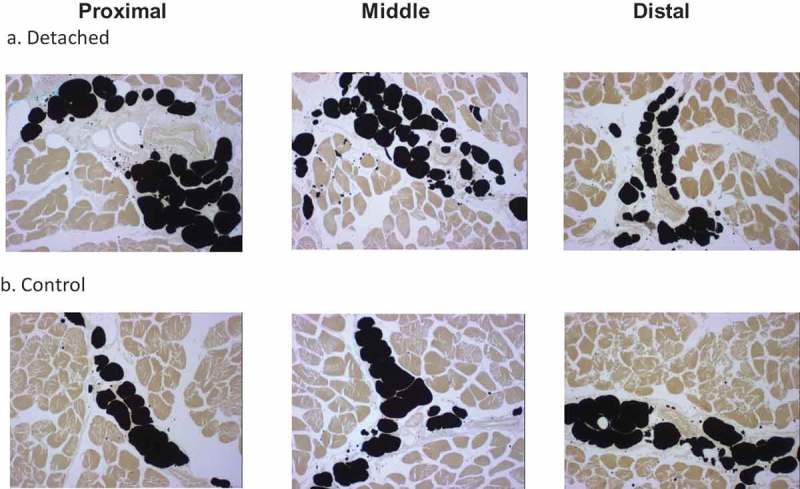
Representative micrographs of adipocytes in the proximal, middle and distal quarters of the SSP muscle. (a). SSP muscle sections at 12 weeks after tendon detachment. (b). SSP muscle sections from control age-matched animals. Adipocyte vacuoles stained black using the osmium tetroxide protocol described in the Method section. Note the increased number of smaller adipocytes in the tendon detached group compared to controls. Original magnification at 25x.